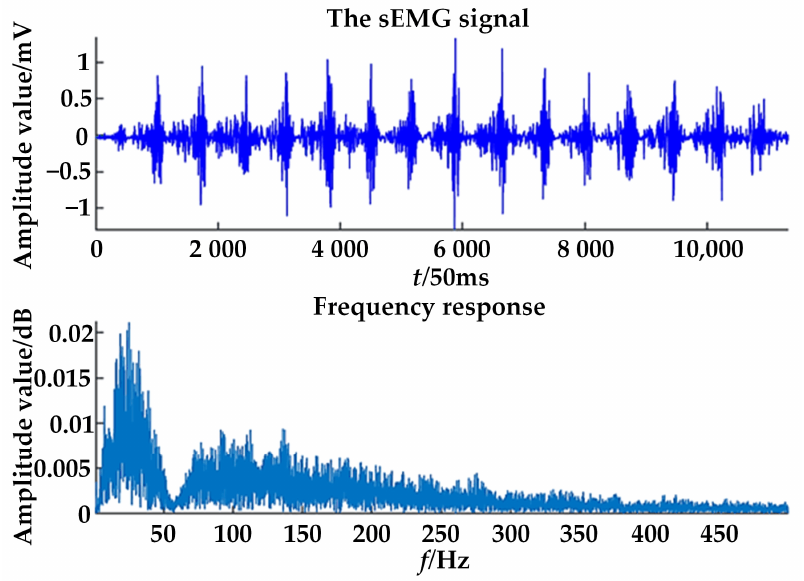
Figure 15. sEMG signals collected during flexion.